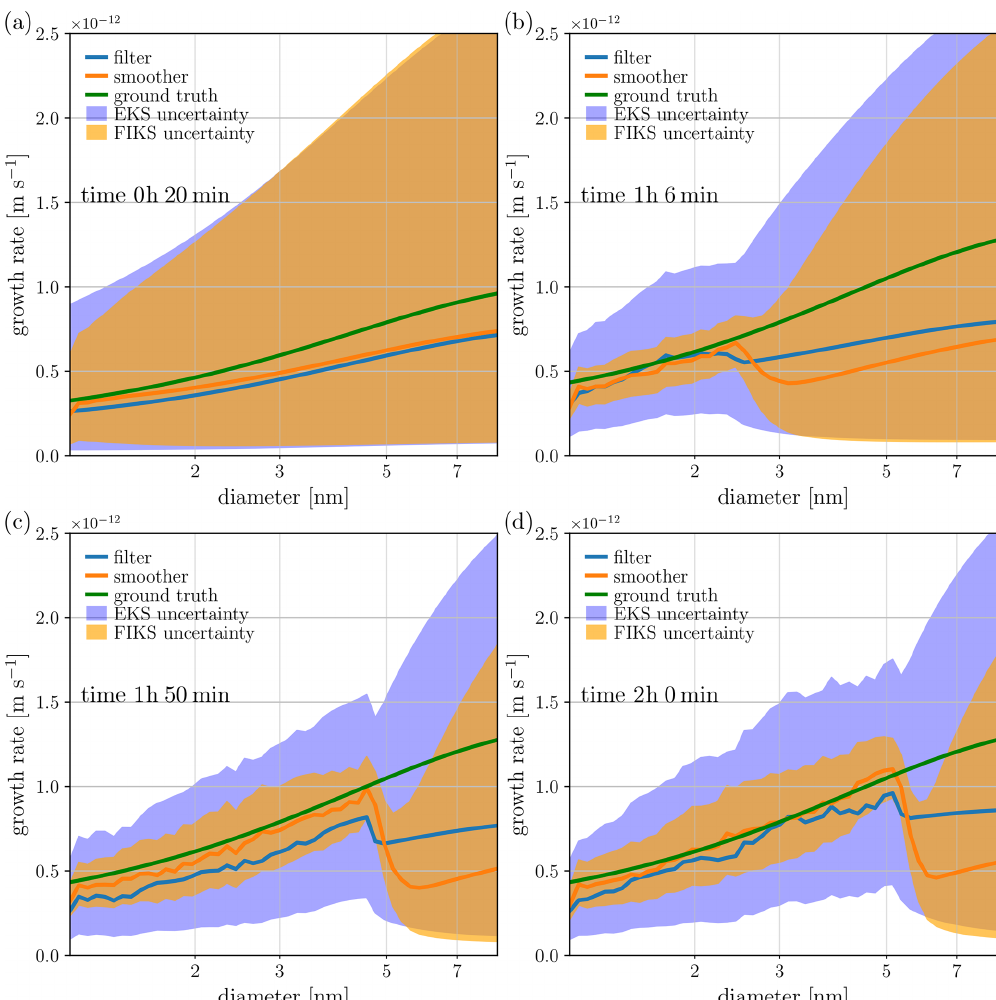
Figure 7. Case 3 – SS and high SNR. Condensational growth rate estimates corresponding to four instants in time. The blue and orange lines represent the approximate posterior expectations for EKF and FIKS, respectively, and the areas shaded with light blue and orange are the respective posterior error intervals. The true growth rates are marked with green